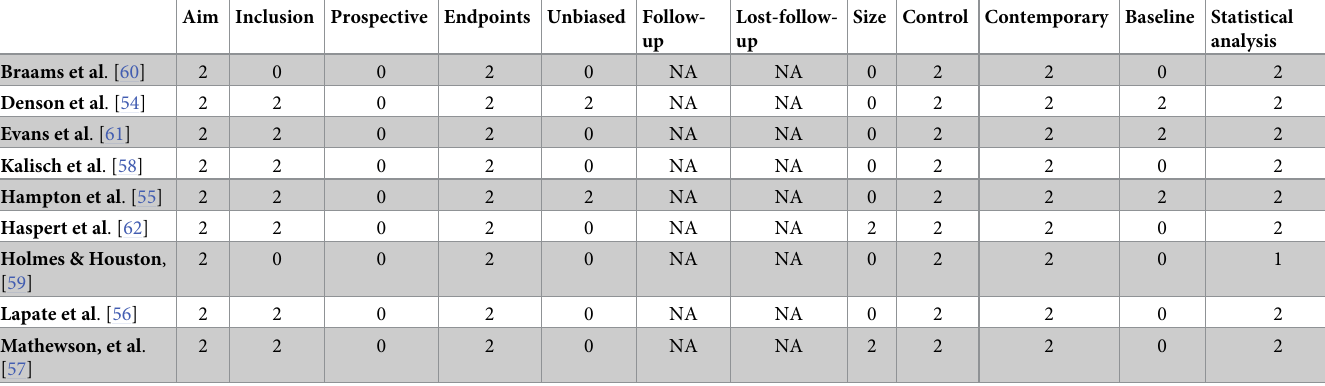
Table 2. Assessment of risk of